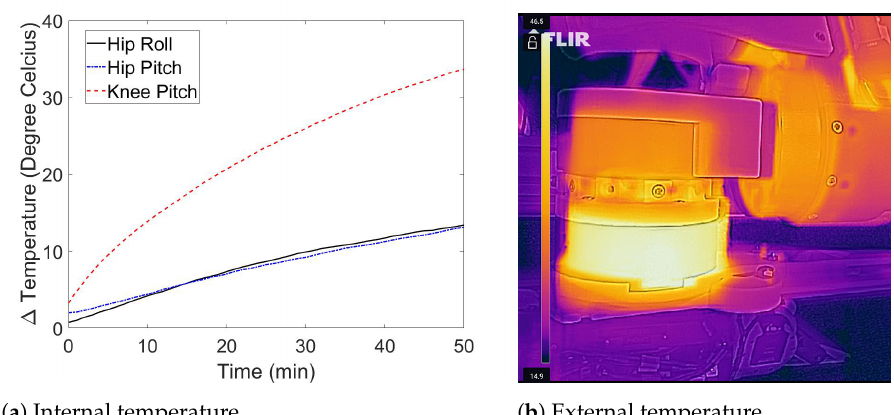
Figure 17. Actuator temperature during the 50 min of continuous walking.